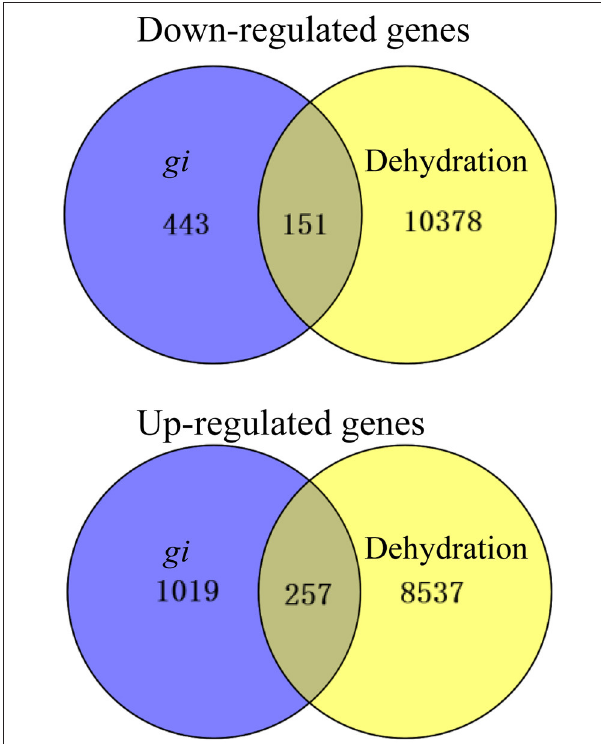
FIGURE 8 | Transcriptomic analyses of osgi and WT seedlings. Venn diagram representing the number of differentially expressed genes in osgi seedlings compared to WT seedlings grown under normal conditions (top; p < 0.05, PPDE > 0.95, 2-fold cut-off) or to WT seedlings exposed to dehydration conditions (bottom; Jain et al., 2007). For the microarray, rice seedlings were grown for 14 days under normal conditions before leaves were harvested.